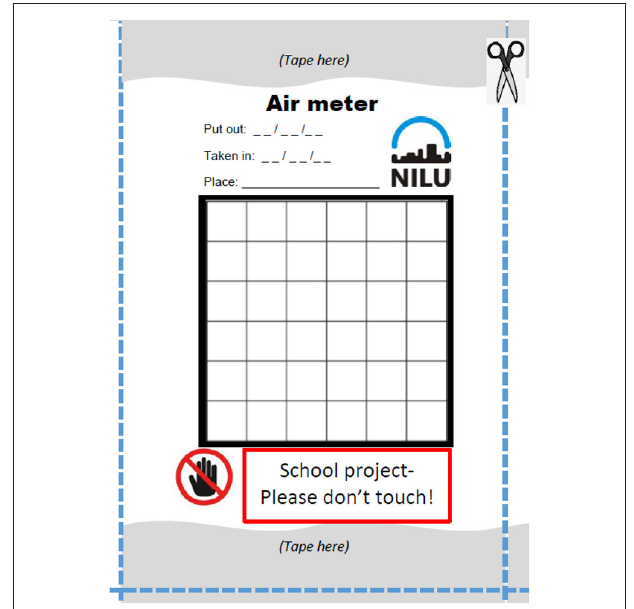
FIGURE 1 | Air meter to monitor dust levels using petroleum jelly. The air meter can be printed in a normal A4 paper and then cut it to have four air meters.